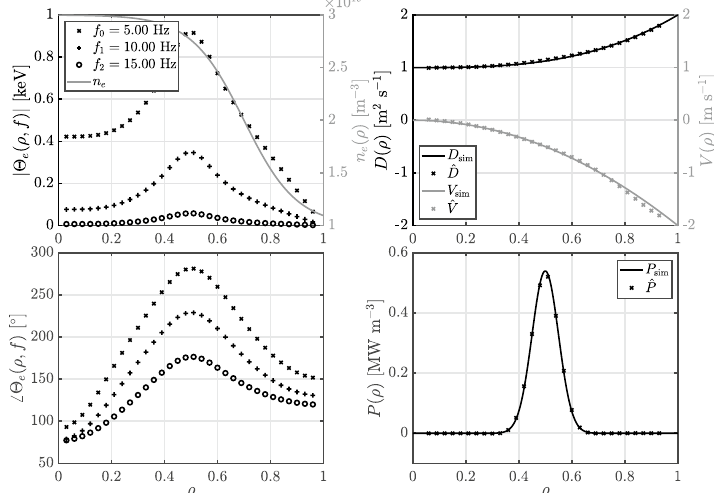
Figure 2. The density and simulated temperature profile (left) with the corresponding simulated and estimated transport parameters (right) for the two different scenario’s: (I) simultaneously estimate of the diffusivity ˆ P source I , and (II) estimate of the diffusivity